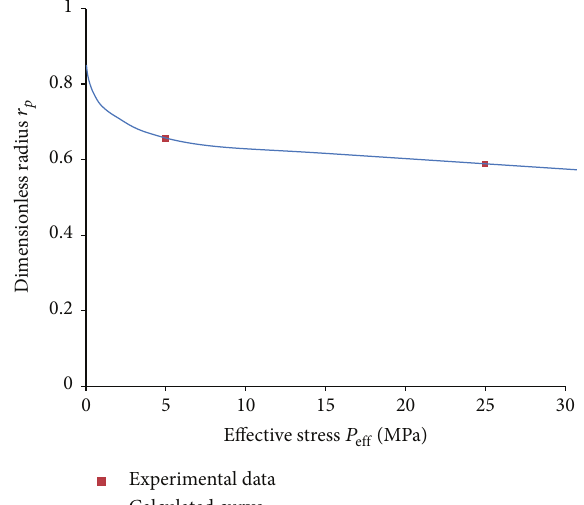
Figure 10: Combination of three pores types. 20% cone [1.0 (60%) + 0.1 (20%) + 0.005 (10%) + 0.001 (10%)] + 30% triangle [1.0 (60%) + 0.1 (20%) + 0.005 (10%) + 0.001 (10%)] + 50% star [1.0 (60%) + 0.1 (20%) + 0.005 (10%) + 0.001 (10%)].